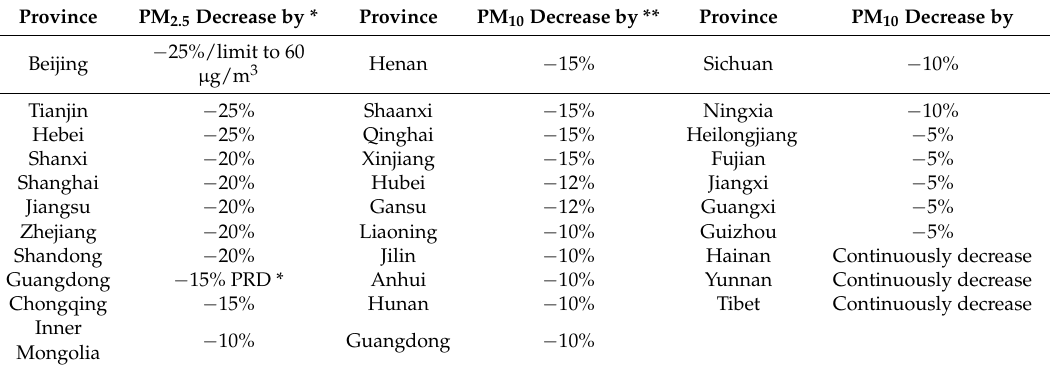
Table A3. Particulate matter decrease targets for the Action Plan at provincial or municipal level.